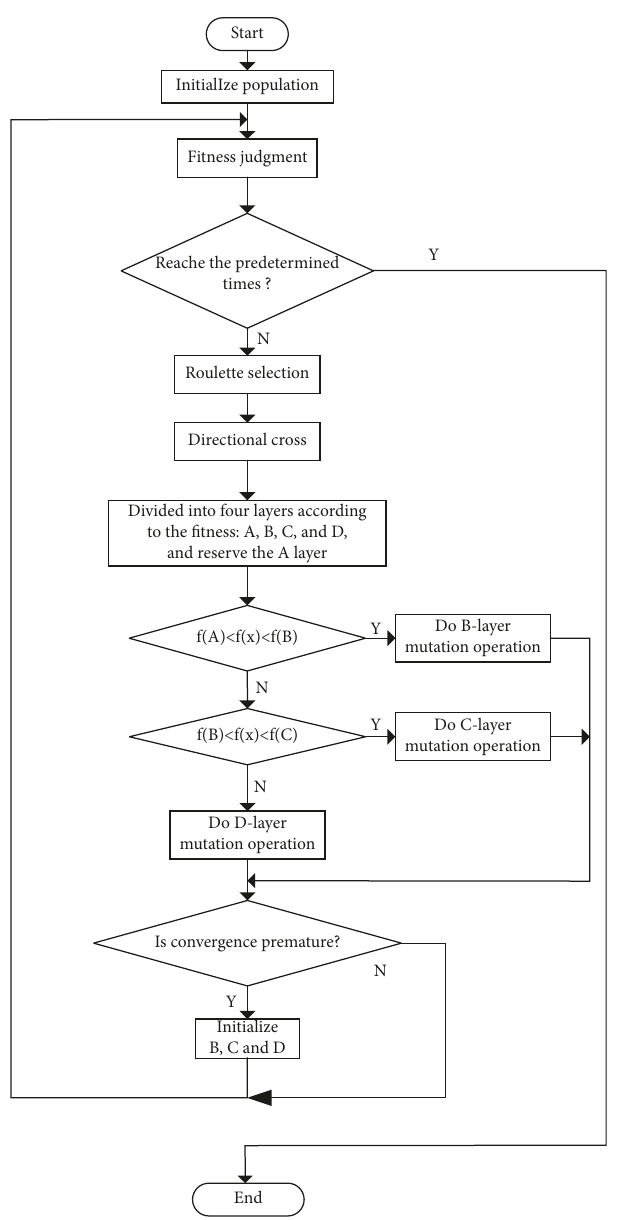
Figure 2: Flowchart of the adaptive directional crossover genetic